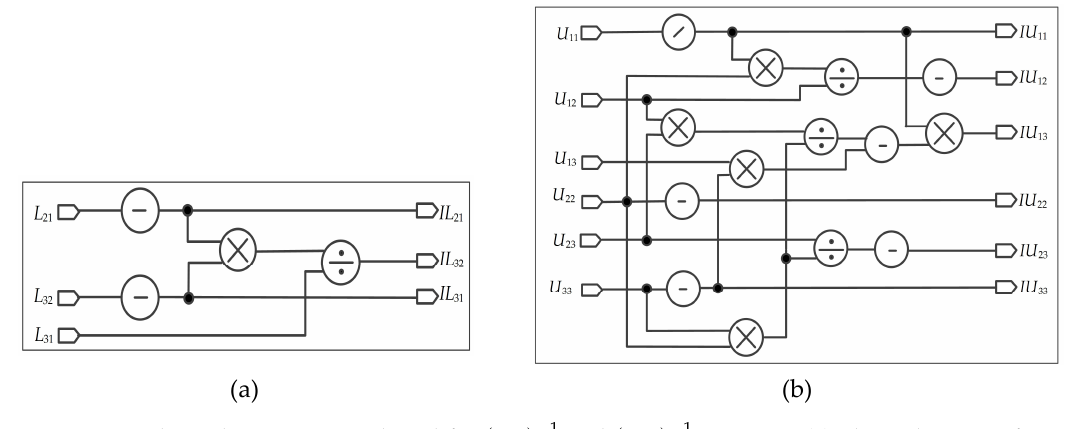
Figure 8. The architecture FPFA-based for ( L 11 ) − 1 and ( U 11 ) − 1 matrices. ( a ) The architecture for